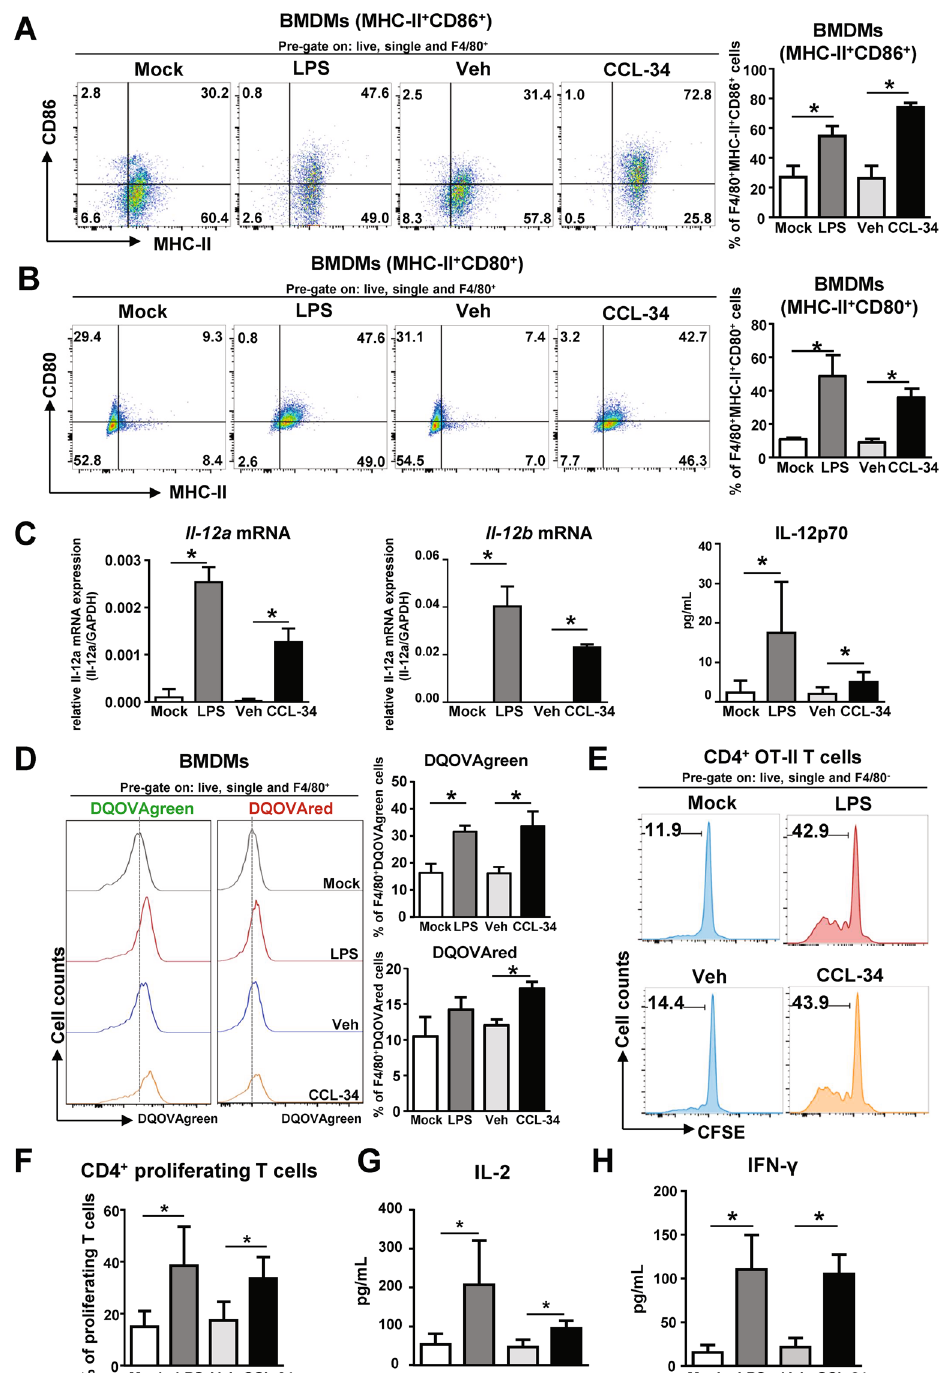
Figure 3. CCL-34-activated macrophages enhanced the proliferation and function of T cells ex vivo . BMDMs generated from C57BL/6 were incubated with LPS (100 ng/mL), vehicle (0.1% DMSO), or CCL-34 (30 μ M) for 24 hours. (A) CCL-34 treatment increases CD86 + MHC-II + F4/80 + cell population. The surface expression of CD86 and MHC-II on BMDMs (CD86 + MHC-II + F4/80 + cells) is shown (n = 4). (B) CCL-34 treatment increases CD80 + MHC-II + F4/80 + cell population. The surface expression of CD80 and MHC-II on BMDMs (CD80 + MHC-II + F4/80 + cells) is shown (n = 3). (C) CCL-34 induced IL-12 in BMDM. Il-12a (Left panel) and Il-12b (Middle panel) mRNA was detected by RT-qPCR (n = 3). The production of IL-12p70 (Right panel) was measured using ELISA (n = 6) (D) CCL-34-activated macrophages show elevated Ag processing activity. BMDMs were incubated with candidate drugs in the combination with 5 μ g DQ-OVA for 24 hours. (Left panel) A representative histogram showing the flowcytometric analysis of DQ-OVAgreen + and DQ-OVAred + BMDMs. (Right panel) The quantitative data are shown (n = 5). (E,F) CCL-34-activated macrophages enhance CD4 + T cell proliferation. Stimulated BMDMs and CFSE-labeled OT-II CD4 + T cells were cocultured for